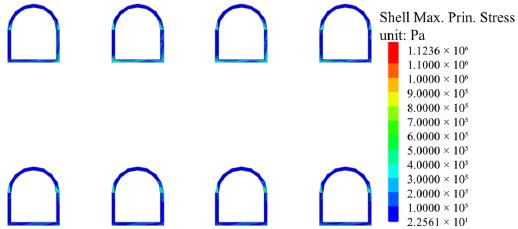
Figure 6. Maximum principal stress distribution of pilot tunnels supporting structure under static excitation.